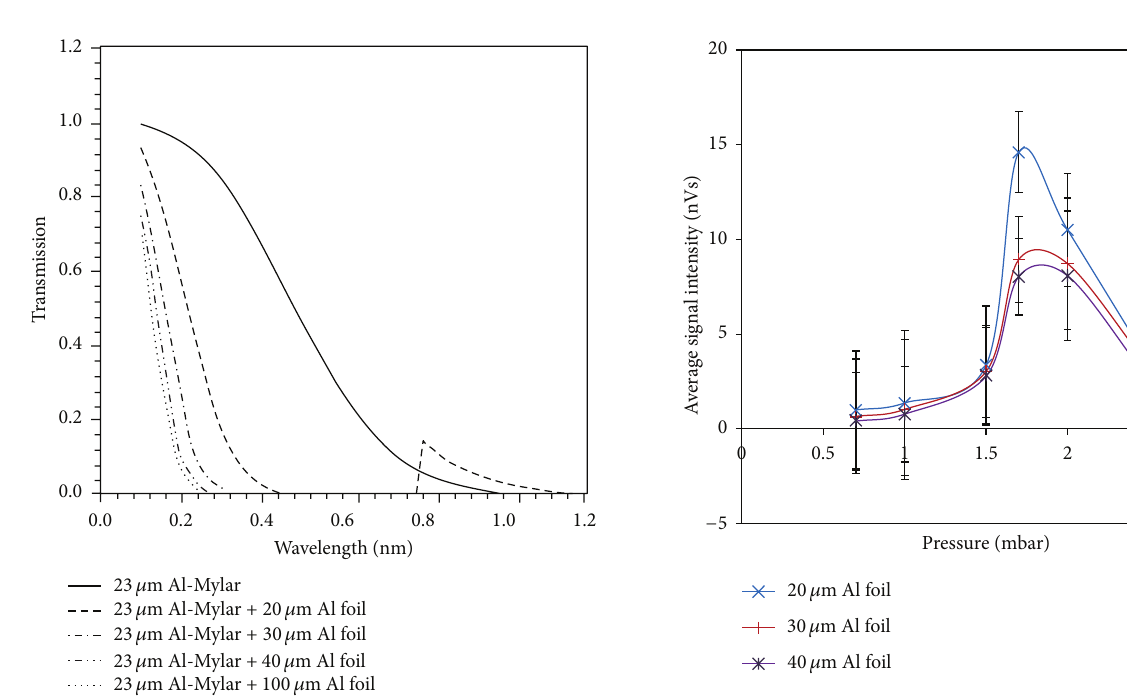
foil, 100 𝜇 m Al foil) were used to determine the X-ray yield.